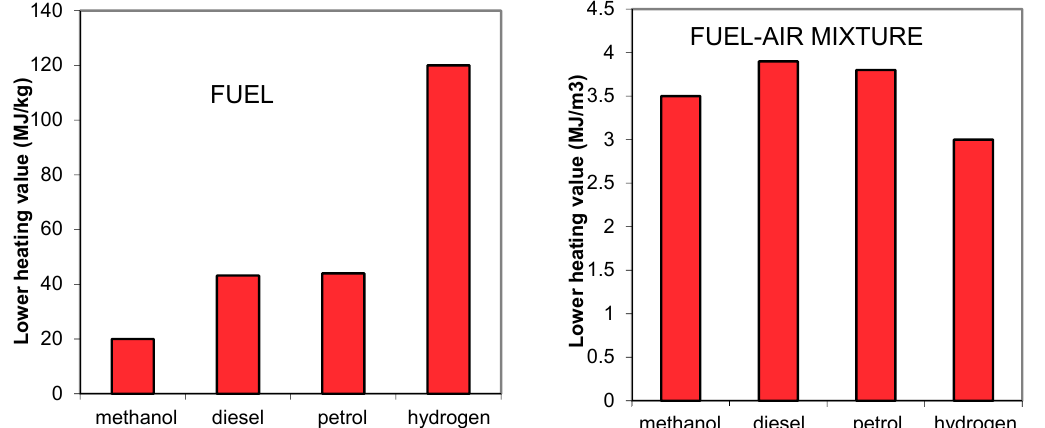
Figure 3. Heating values for the fuel (per mass) and for the stoichiometric air-fuel mixture (per unit volume—[25]).